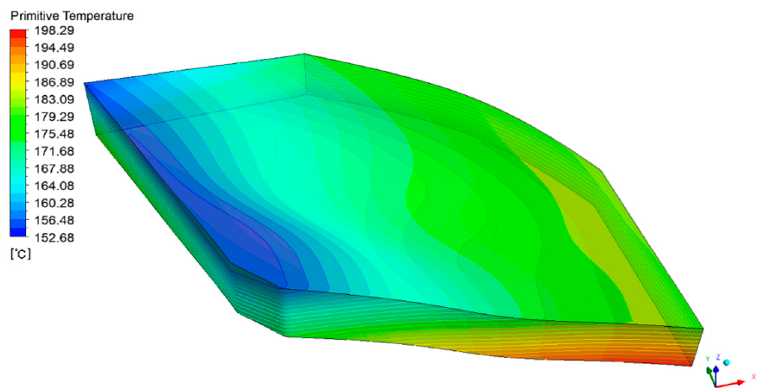
Figure 5. Reservoir initial temperature distribution.